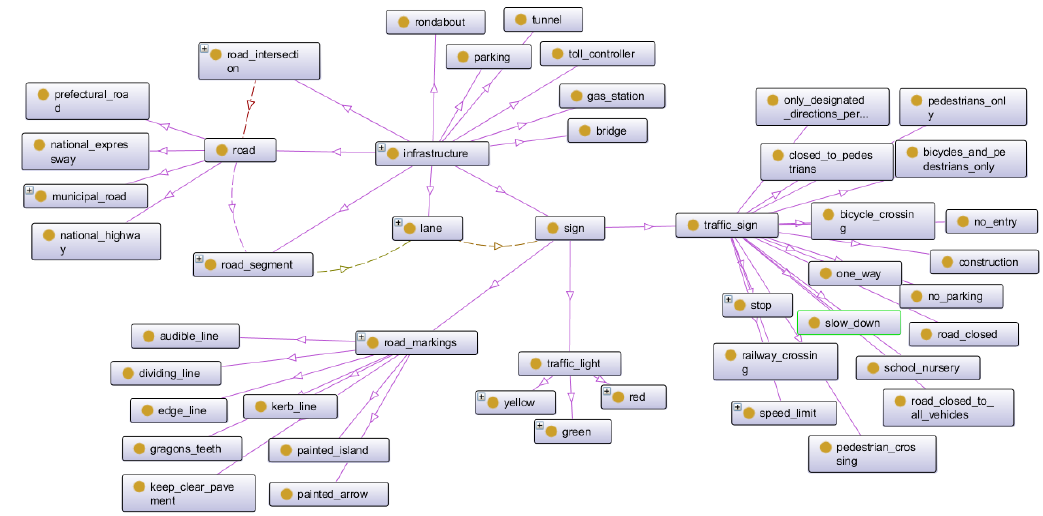
Figure 3. Concepts related to infrastructure.